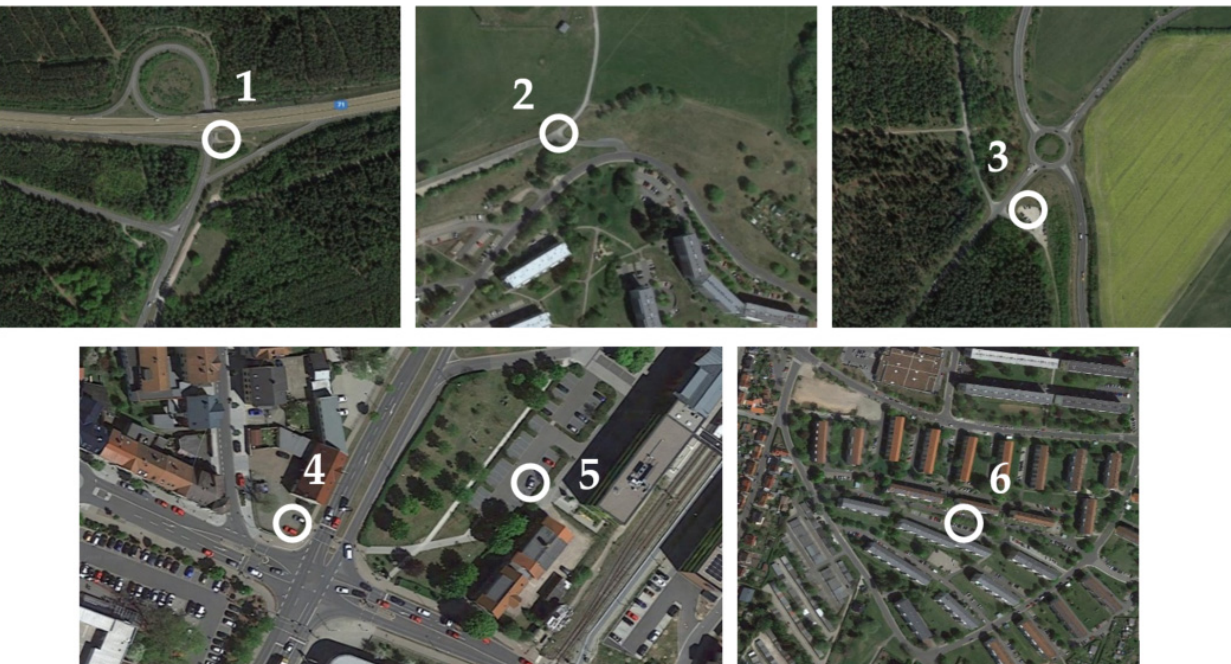
Figure 8. Defined measurement positions for assessing particle pollution in different environments